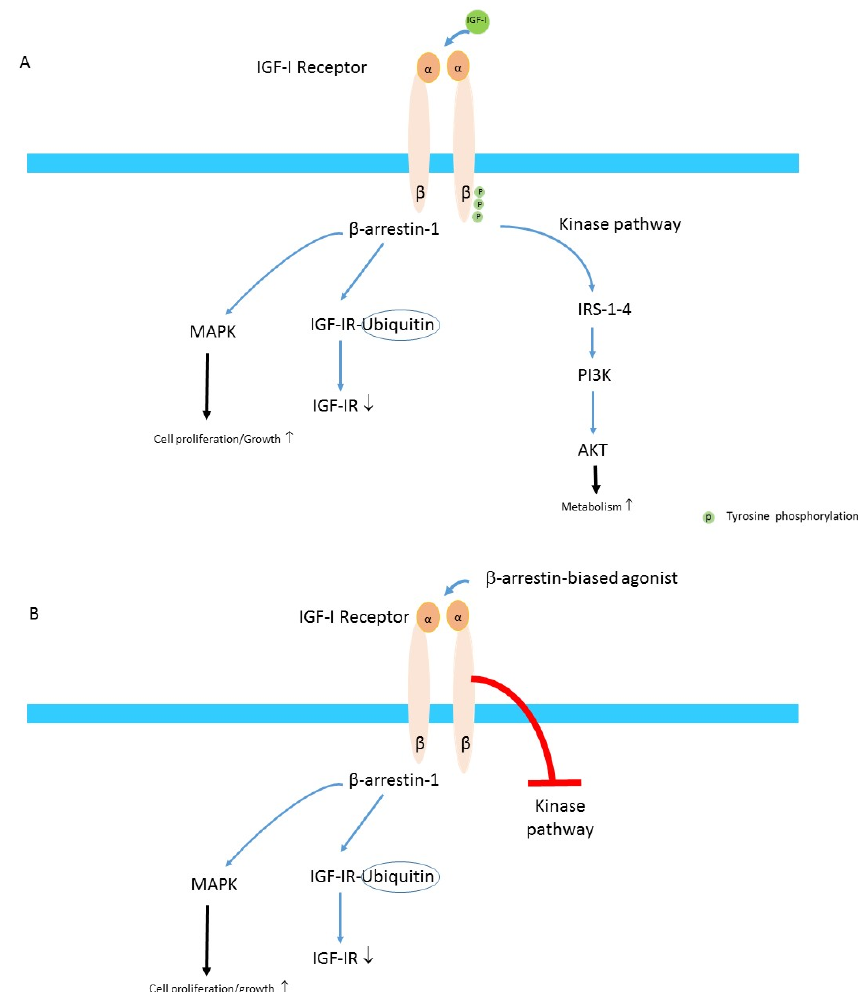
Figure 2. ( A ) Balanced agonism. Binding of IGF-I to the IGF-IR induces stimulates both the β -arrestin-1 pathway that leads to MAPK activation and proteasome degradation of the IGF-IR through an ubiquitin-mediated mechanism resulting in a loss of the number of IGF-IRs at cellular membrane. IGF-I binding to the IGF-IR also induces phosphorylation of tyrosine residues and this stimulates the kinase pathway which finally activates AKT. ( B ) β -arrestin-1-biased agonism. Binding of a biased agonist preferentially increases β -arrestin-1 signaling and this simultaneously inhibits the IGF-IR kinase pathway. Thus, β -arrestin-1-biased agonism results in down-regulation of the IGF-IR and inhibition of AKT signaling, but increases MAPK-mediated cell proliferation and growth (Modified from Salisbury & Tomblin. Insulin/Insulin-like growth factors in cancer: new roles for the aryl hydrocarbon receptor, tumor resistance mechanisms, and new blocking strategies [26]. In hybrids α-β IGF-IR subunit are linked by disulfide bonds to α-β IR. Both IR-A/IGF- IR (Hybrid A) as well IR-B/IGF-IR (Hybrid B) receptors can be formed [27]. The biological functions of these hybrids remain uncertain without examining cells not expressing holo- IGF-IR or holo-IR [28]. Nevertheless, it has been suggested that IR/IGF-IR hybrids act in a manner similar to that of IGF-IR. Hybrid receptors respond more predictably to IGF-I than